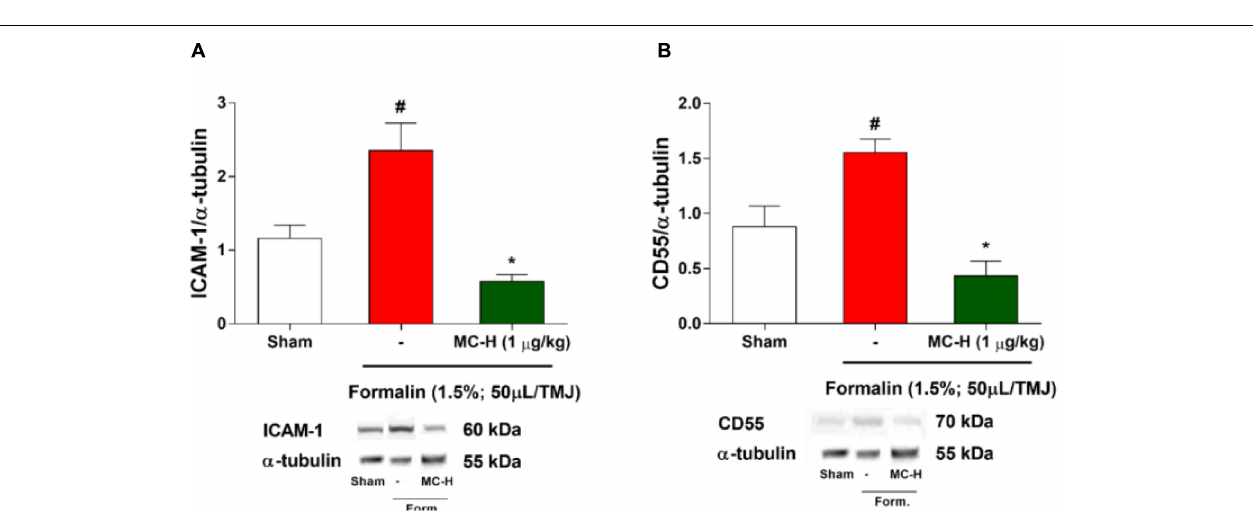
FIGURE 2 | Three-dimensional representation of molecular dockings between MC-H and the molecular targets of interest. (A) ICAM-1, (B) CD55, (C) HO-1, (D) iNOS, (E) soluble cGMP, (F) cGMP-dependent protein kinase (PKG), (G) K + ATP channel, (H) mu ( µ ) opioid receptor, (I) kappa (k) opioid receptor, and (J) delta ( δ ) opioid